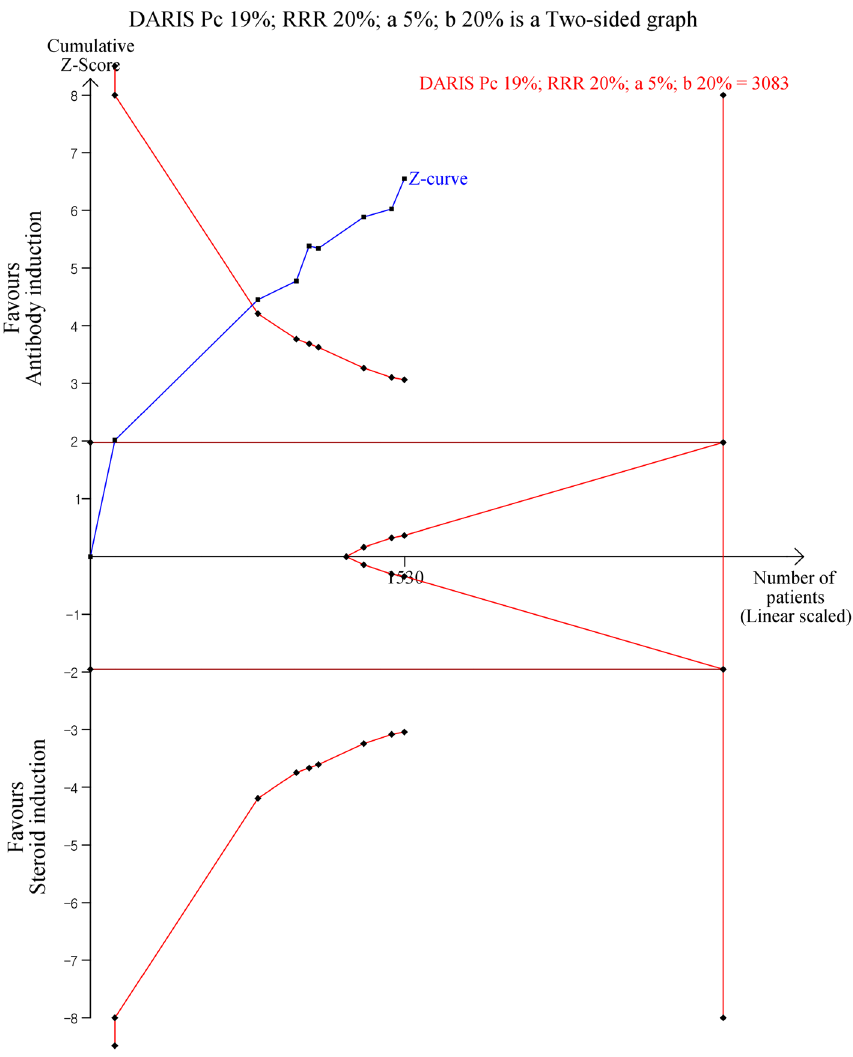
Figure 4. Trial sequential analysis for new-onset diabetes mellitus. DARIS = diversity-adjusted required information size, Pc = Probability in the control group, RRR = relative risk reduction, a = alpha error, b = beta-